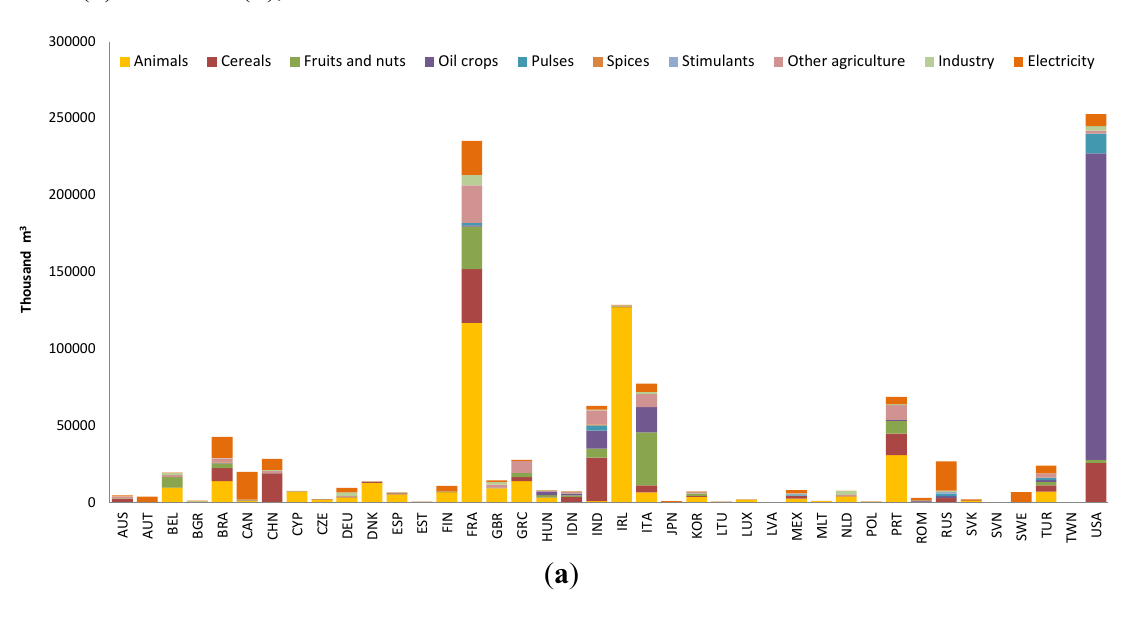
Figure 1. Blue virtual water exports of the food sector by country and sector in 1995 ( a ) and 2009 ( b ), thousand m 3 .